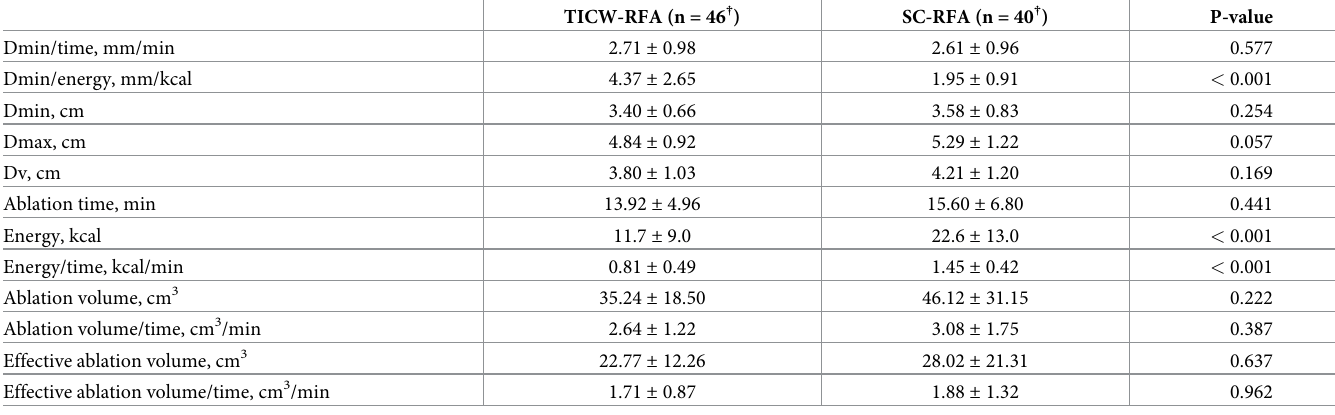
Table 2. Comparison of technical parameters between TICW-RFA and SC-RFA